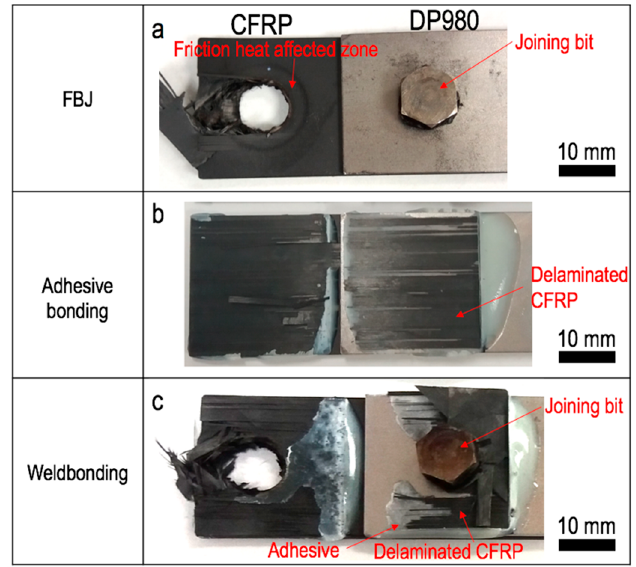
Figure 6. Comparison of fractography results for lap shear-tested ( a ) FBJ, ( b ) adhesive-bonded, and ( c ) weld-bonded specimens.